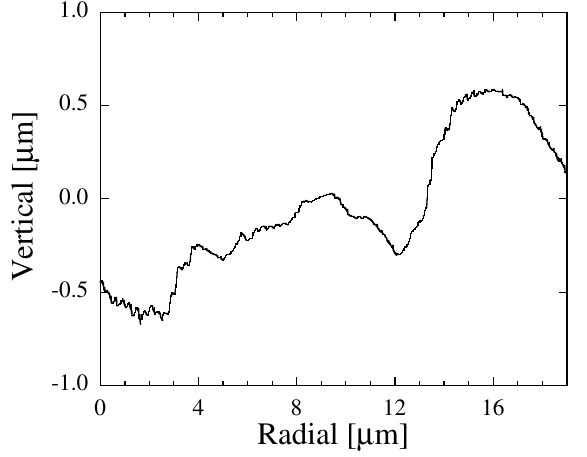
FIG. 9. Same as Fig. 8, but as a function of macroscopic field due to changes in anode potential for two cases: 22 mJ of laser energy for a bulk temperature of 713 K, and 12 mJ of laser energy for a bulk temperature of 633 K. Note that the surface coverage factor ! changes.